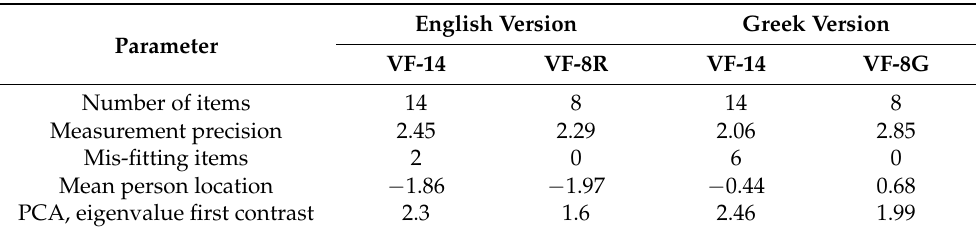
Table 4. Rasch-based metric properties of the English and Greek VF-14 scales and the short versions proposed by Gothwal et al. [5] and this study (VF-8G).